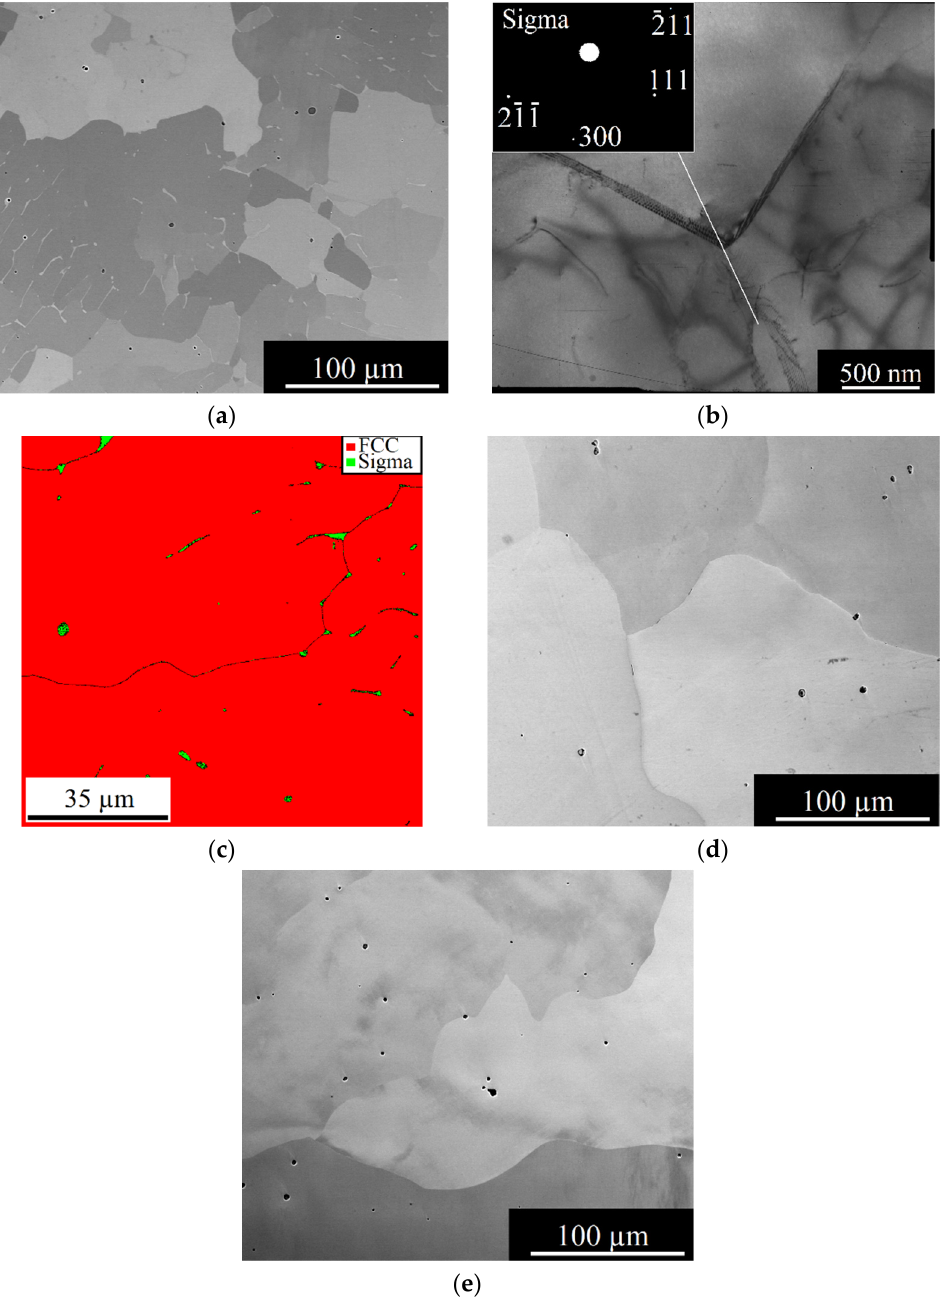
Figure 1. Microstructure of the Fe 40-x Mn 40 Cr 10 Co 10 N x alloys in the as-cast state: N0 ( a – c ); N0.5 ( d ); N2.0 ( e ); SEM-BSE images ( a , d , e ) TEM image ( b ); EBSD phase map ( c ).